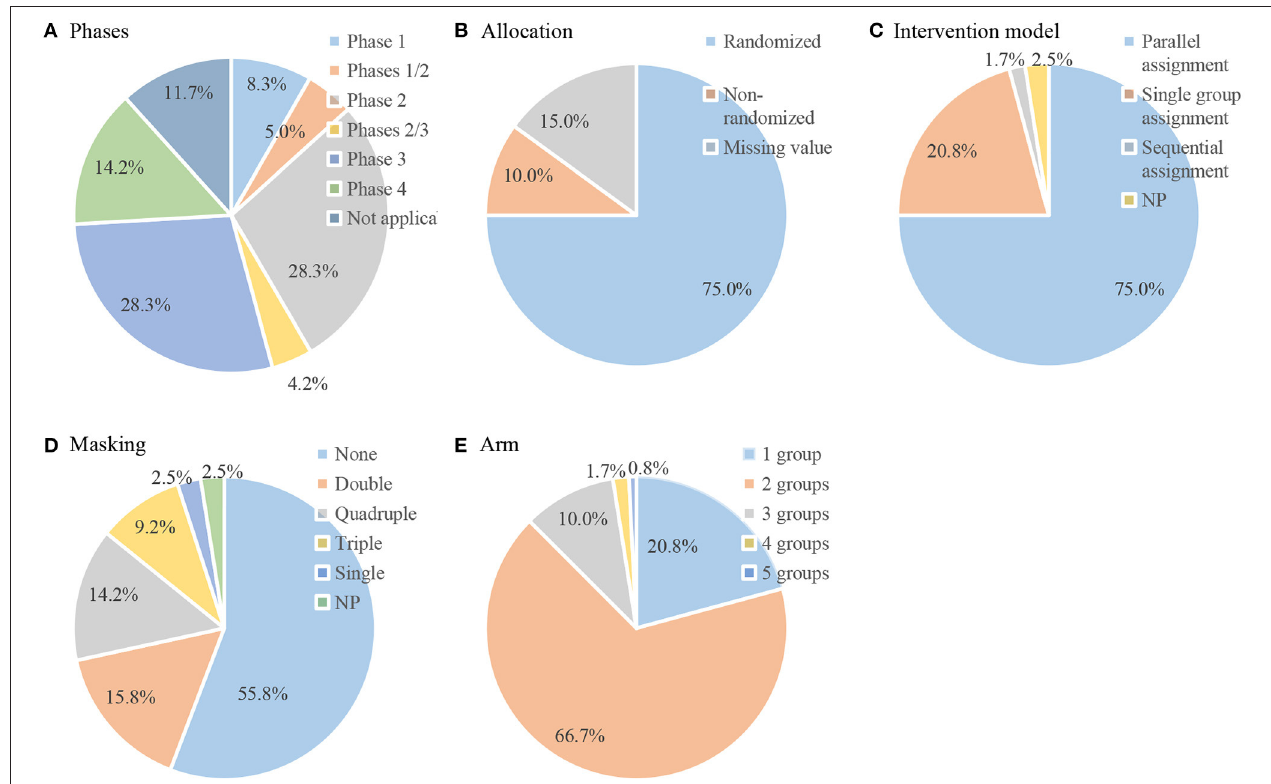
FIGURE 3 | Design data of included interventional trials ( n = 120). Pie chart of (A) phases; (B) allocation; (C) intervention model; (D) masking; (E)